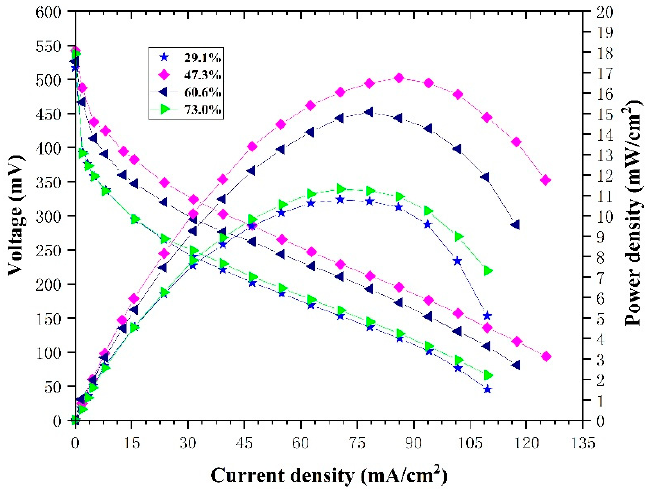
Figure 12. Polarization curves and power density curves of single-serpentine flow fields with different open ratios under the same experimental conditions.